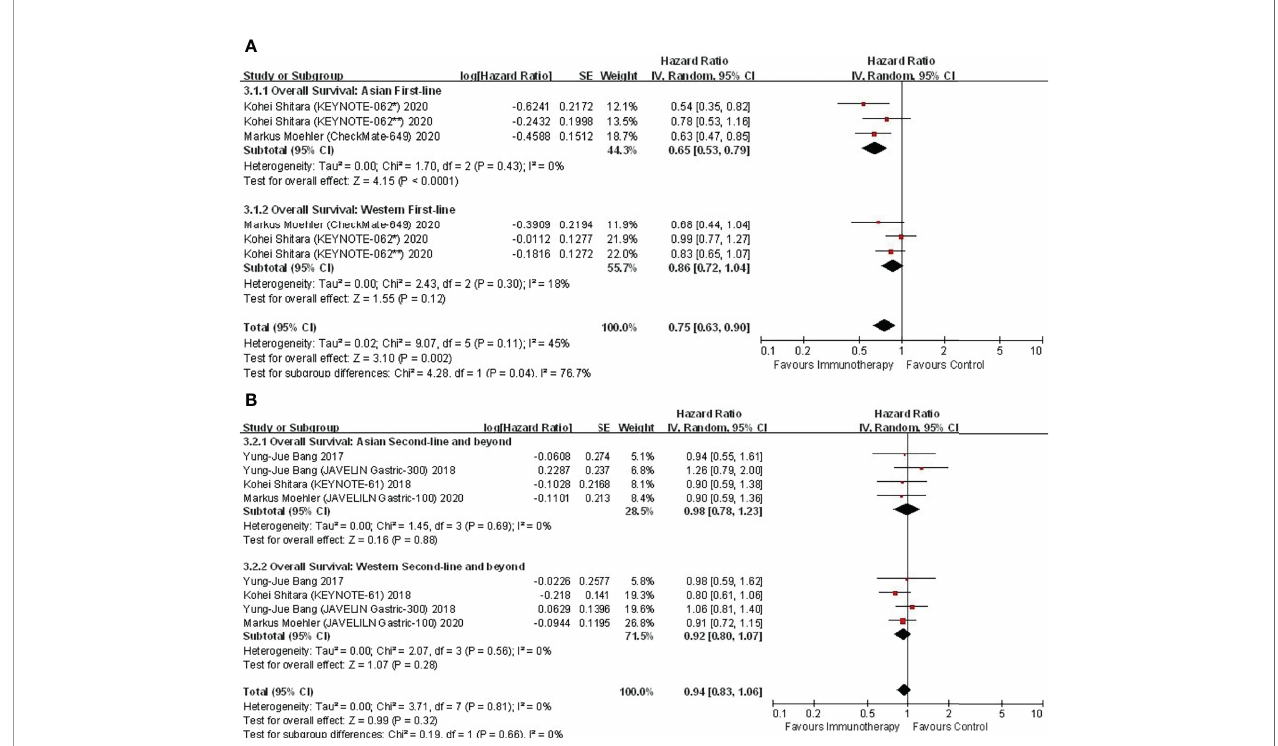
FIGURE 3 | Comparison of regional subgroup differences in OS according to fi rst versus subsequent lines of immunotherapy. (A) fi rst-line; (B) second-line and